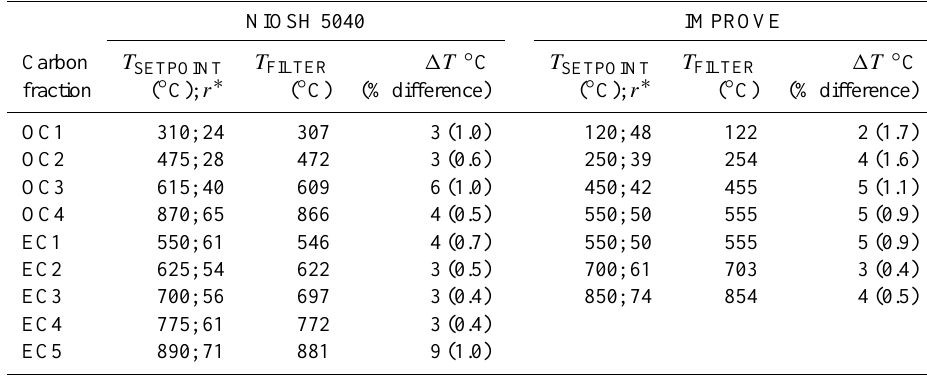
Table 3. Filter temperatures measured after calibration and software